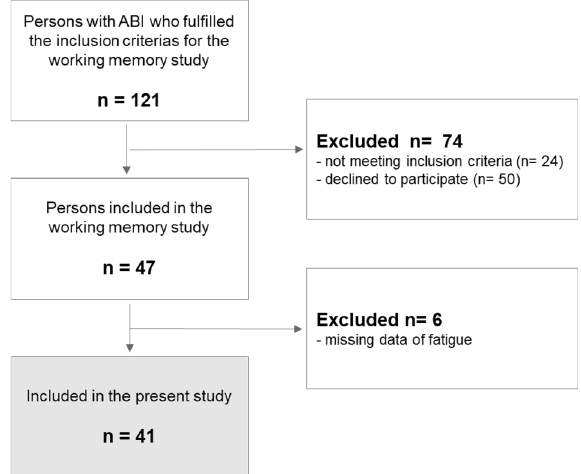
Figure 1. Flowchart of the study